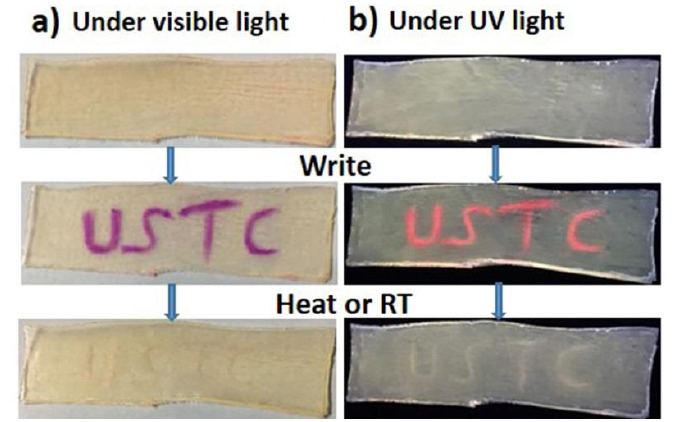
Figure 5. The abbreviation of our university, “USTC”, was written on the hydrogel, and it was erased by heating or at room temperature automatically. ( a ) Images taken under visible light; ( b ) fluorescent images taken under UV light.